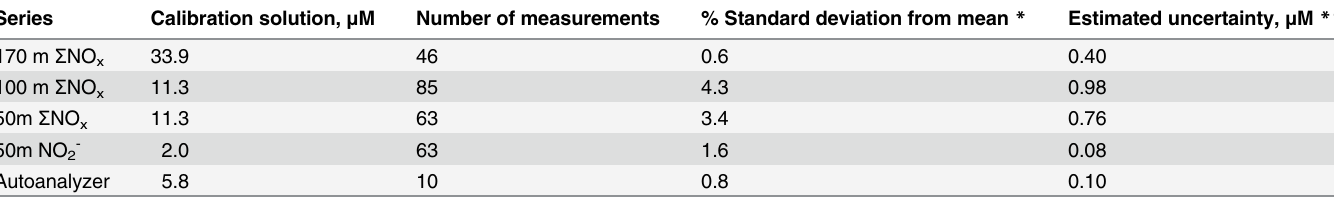
Table 2. Summary of the analytical performance derived from in situ measurements of standard solutions (for LOC) and on board measurements (Autoanalyzer).